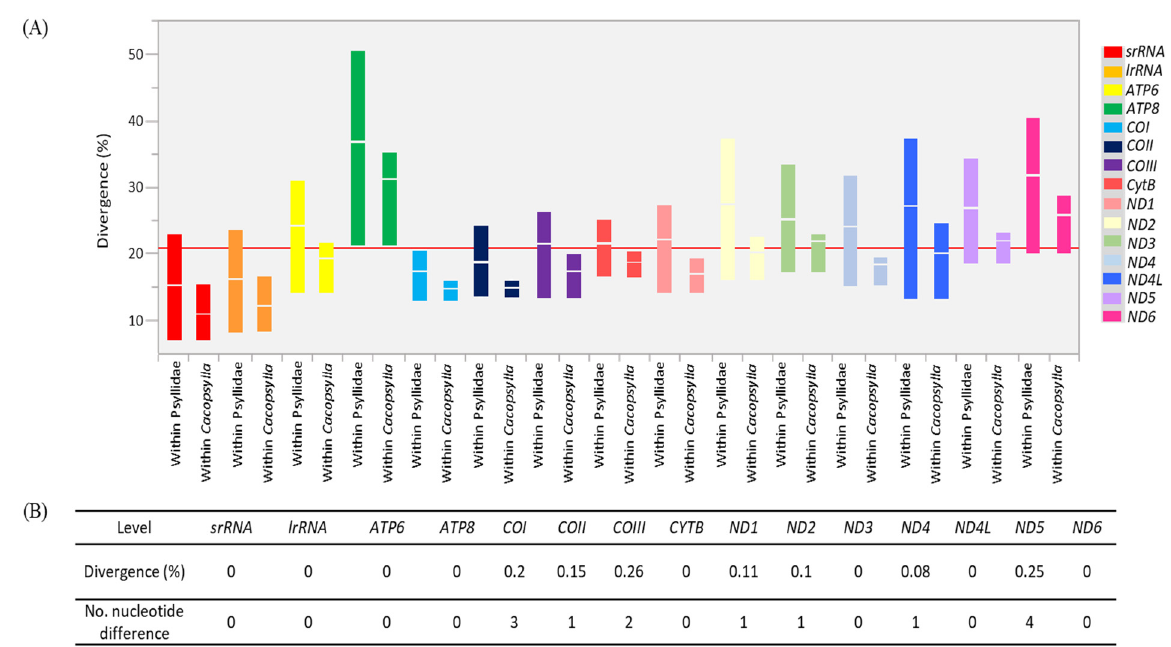
Figure 3. Sequence divergence of each protein-coding gene (PCG) and rRNA in Psyllidae. ( A ) Boxplot distribution of within-genus ( Cacopsylla ) and within-family (Psyllidae) genetic divergence for 13 PCGs and two rRNAs in Psyllidae. Top, middle, and bottom of bars indicate maximum, average, and minimum divergence (%), respectively; the red horizontal line represents the median of sequence divergence (%) in Psyllidae. ( B ) Divergence between two Cacopsylla burckhardti .